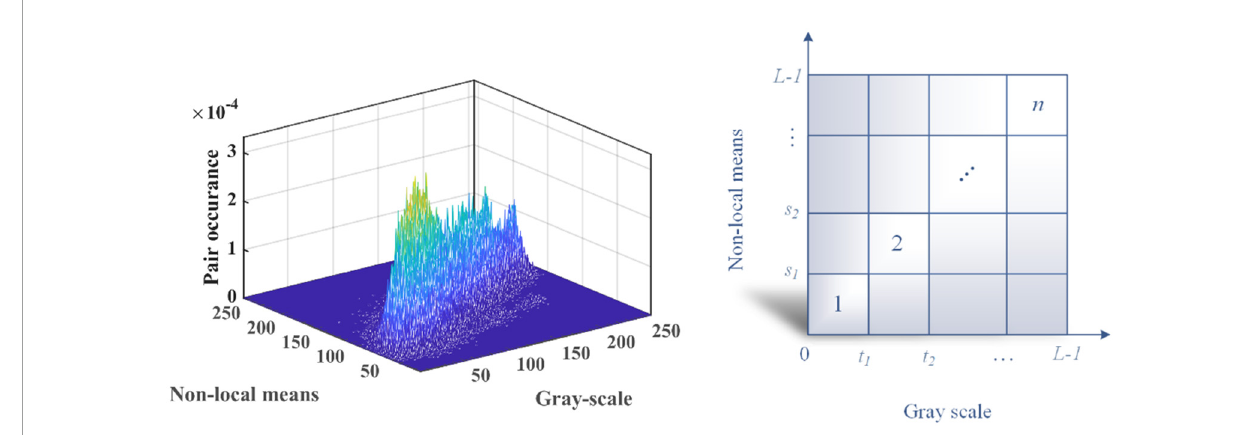
FIGURE4 The 2D histogram and the 2D plan